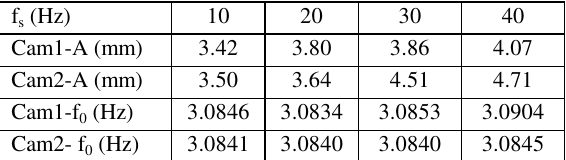
Table 1. Maximum deformation and estimated loading